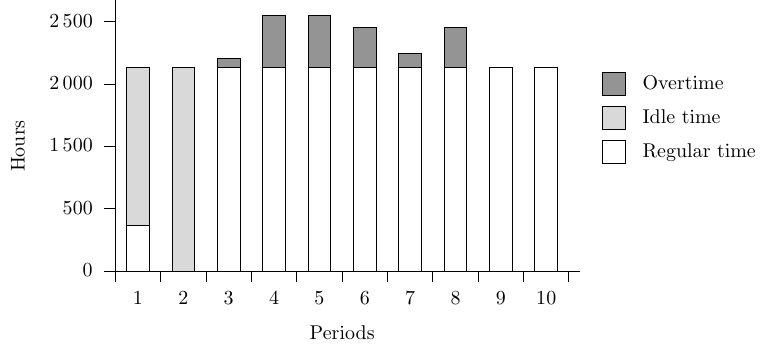
Figure 1: Comparison of total time, regular time, overtime and idle time that occurs in a 10- period model solution with naively set initial inventory level of raw materials at 25 950 kg, which yielded a profit of US$935